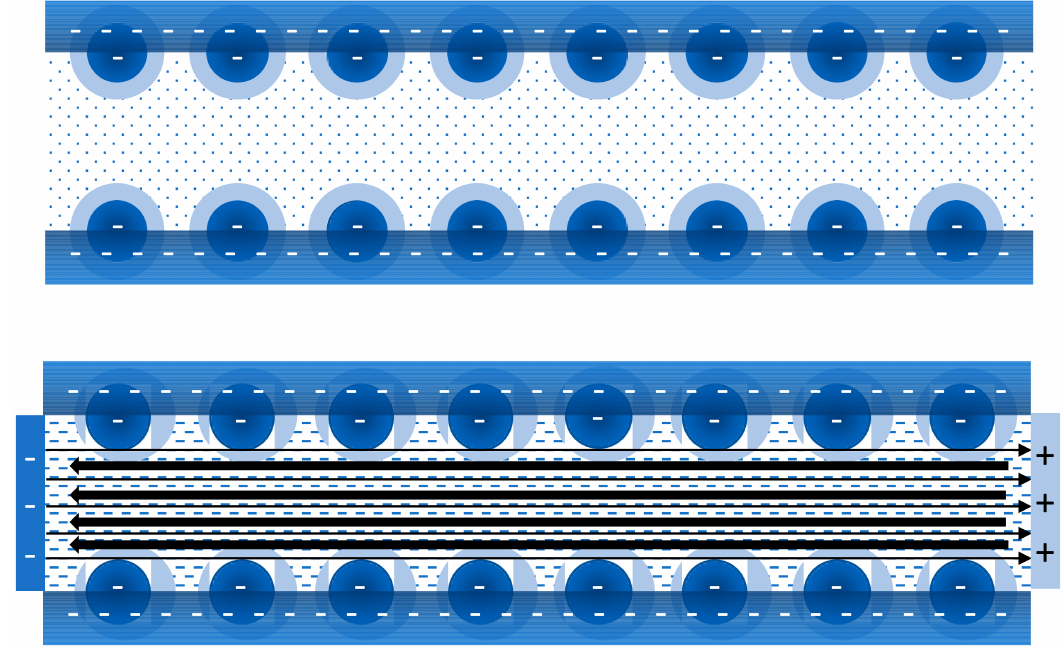
Figure 3. Scheme for the description of the primary electroviscous effect in a porous plug. It is assumed that the sign of the charge developed onto the particle surface is negative. Therefore, the EDL is mainly positive. At rest (figure on the top) the EDL maintains its symmetry. However, when a pressure difference generates a flow along the capillaries of the porous plug from left to right (figure on the bottom), the distortion of the EDL gives place to an excess of positive charge at the right part of the porous plug. Consequently, an electric field pointing from right to left is induced, generating an electro-osmotic effect on the positive ions (counter-ions in this case) that reduces the velocity of the flow, i.e., the viscosity is apparently